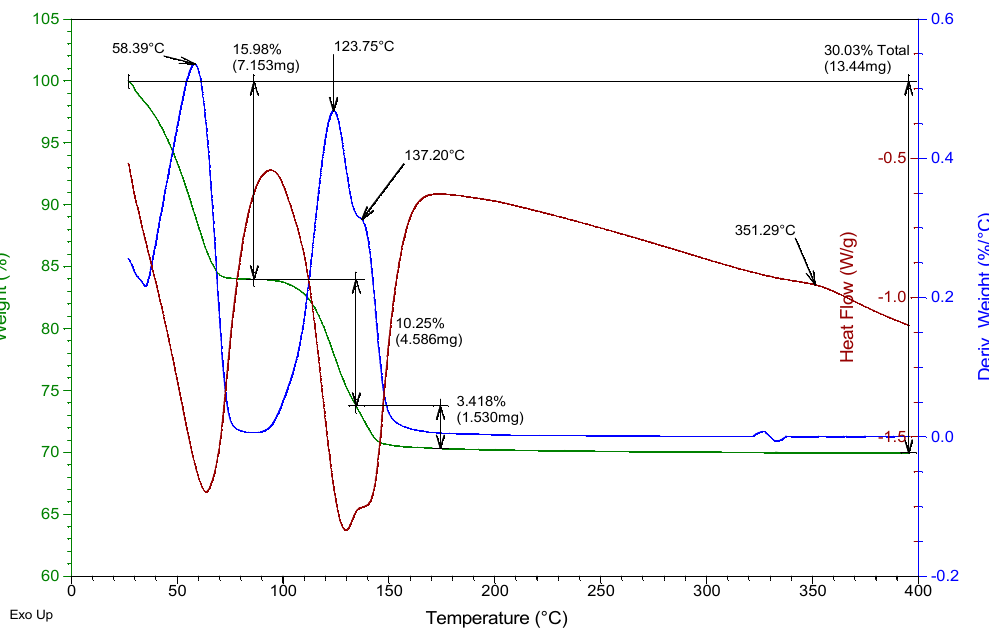
Figure 11. Thermogravimetric analysis of the test tube YF-0.8 aged 1 day.